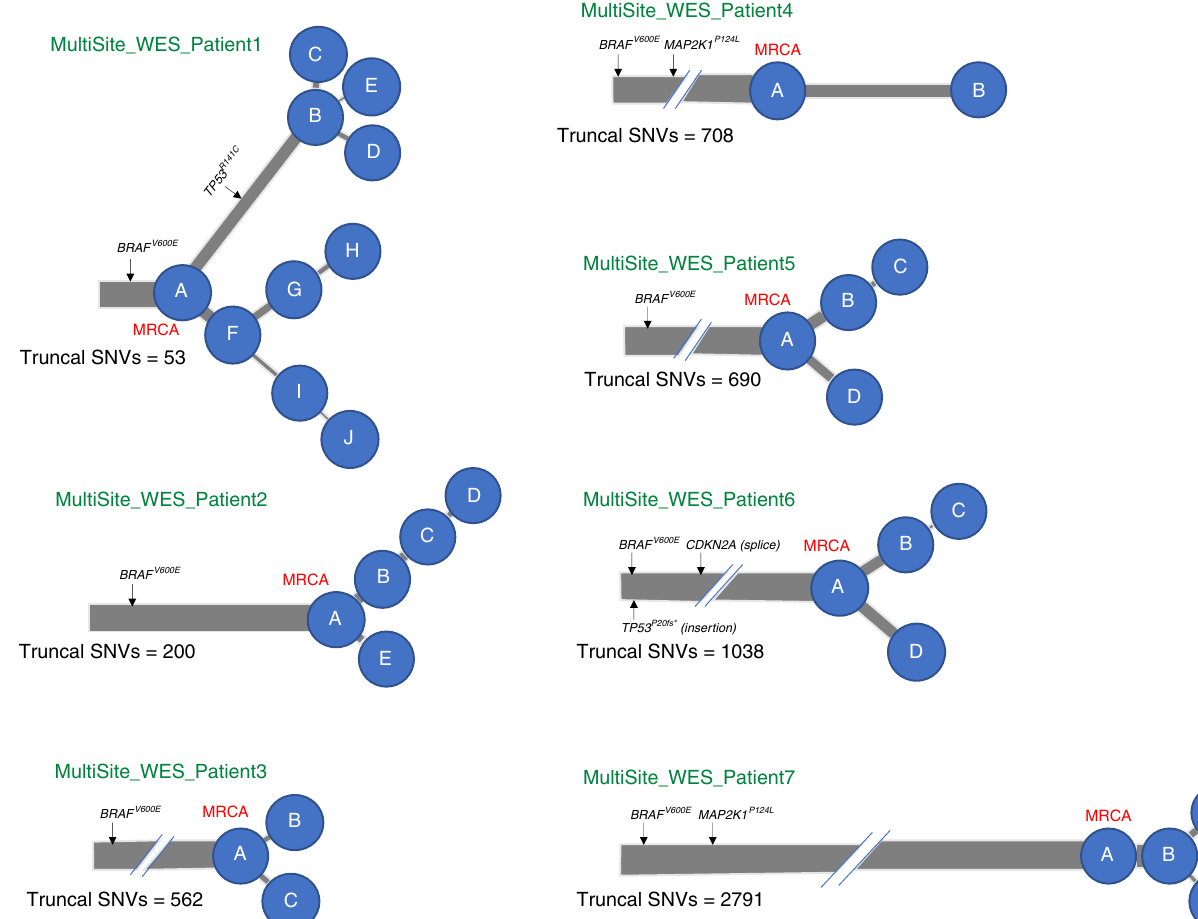
Fig. 3 Multi-dimensional clustering across metastases from 7 patients uncovers divergent lineages. Phylogenetic trees of 7 metastatic melanoma patients are indicated, with branch lengths proportional to the number of SNVs within the mutation cluster and branch thickness proportional to the average CCF of the cluster (across all the samples within each patient). The number of truncal SNVs is indicated underneath the respective phylogenetic trees, most recent common ancestor (MRCA) is labelled in red. All patients harboured an activating BRAF V600E driver mutation. In keeping with previous reports 17,19 , all other melanoma drivers were represented on the trunk (rather than the branches) of the phylogenetic trees, except for one patient (MultiSite_WES_Patient1) harbouring a previously unreported TP53 R141C mutation which was unique to one branch and completely absent in the three samples on the opposing branch (despite adequate coverage,